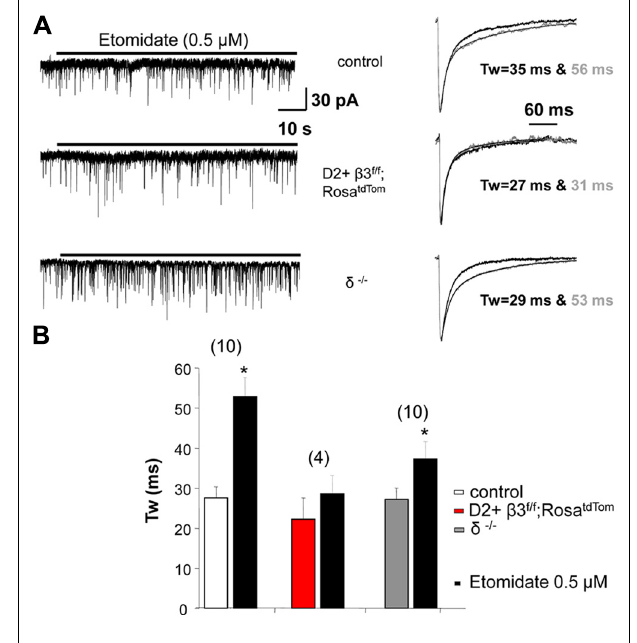
FIGURE 3 | GABA A receptor subunits affect response to etomidate. (A) Example traces at a slow time scale ( left ) illustrating the lack of effect of 0.5 μ M etomidate on holding current in D2 + MSNs deriving from control and β 3 f / f ;Rosa tdTom compared to unidentified MSNs from δ − / − mice. On the right are shown superimposed the average normalized sIPSCs with exponential fits and weighted decay time constant in the absence and the presence of etomidate. (B) Summary graph comparing the weighted decay time constant of average sIPSCs measured in MSNs from the three genotypes in the absence and the presence of 0.5 μ M etomidate. ∗ p < 0.05 paired two-tailed Student’s t test (control group) orWilcoxon matched pairs test.The average increase in T w in δ − / − MSNs is less compared to control but the difference is not